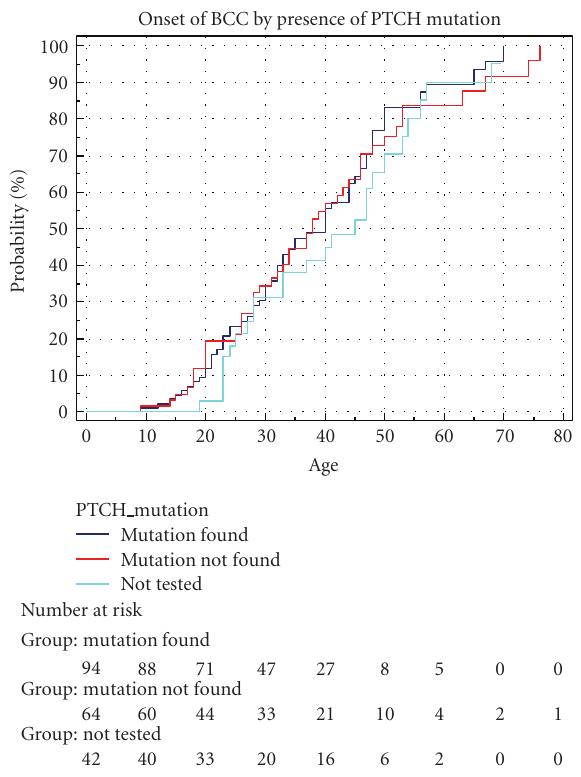
Figure 2: Cumulative onset of BCC by presence of PTCH mutation. Mutation found (y) n = 94. Not found (n) n = 64. Untested (u) n =